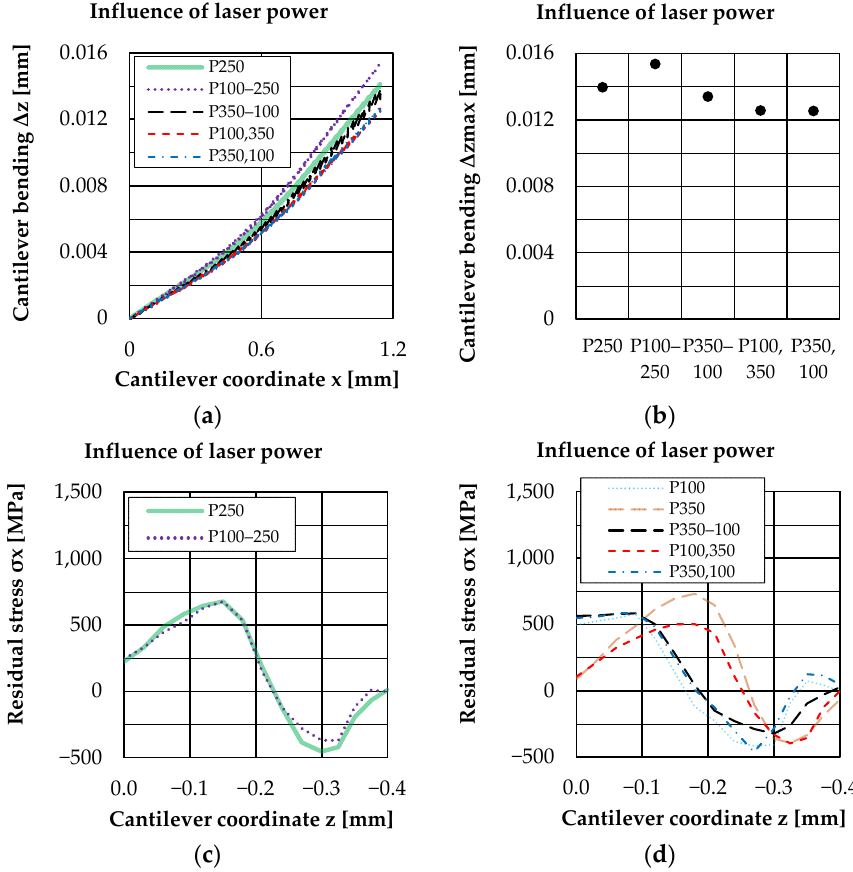
Figure 10. Cantilever bending ( a , b ) and residual stress ( c , d ) for laser power variation from layer to layer.